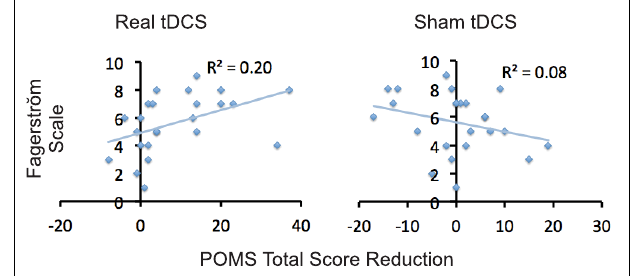
FIGURE 3 | Correlations between level of nicotine dependence and tDCS-induced reduction of negative affect . Scatter plots demonstrate correlations between scores on Fagerström and reduction in POMS total scores after tDCS relative to before tDCS.